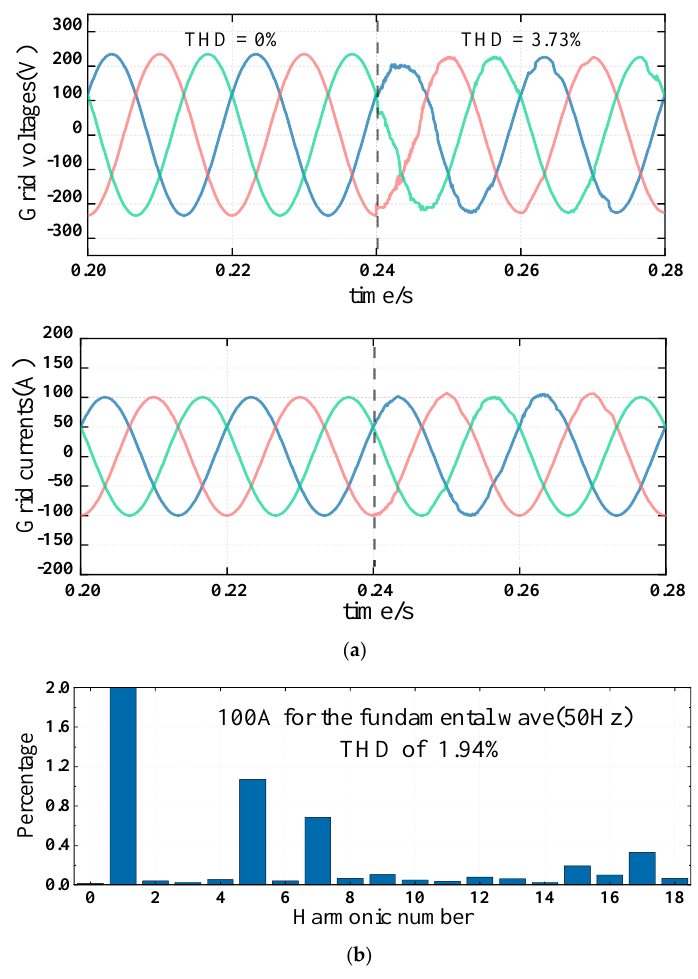
Figure 12. Analysis of i M waveform and FFT before and after grid voltage harmonic wave surge. ( a ) Waveforms of incoming voltage u M and current i M before and after the sudden increase in voltage distortion in the power grid; ( b ) FFT analysis of grid-connected current i M after grid voltage dithering.